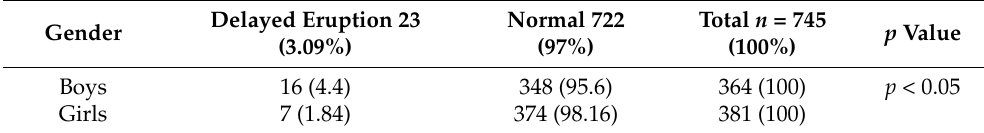
Table 2. Frequency distribution of delayed eruption cases according to different variables. n = 745 Boys Girls Total (100%) Delayed Eruption 16 (70%) 7 (30%) 23 Unilateral 13 (72%) 5 (28%) 18 Bilateral 3 (60%) 2 (40%) 5 cases with delayed eruption, 18 (78%) were unilateral, and 5 (22%) presented a bilateral delayed eruption within the upper centrals. The most commonly affected tooth was the upper left central incisor with a total number of 13 cases, followed by the upper right central incisor with a total number of 12 cases either unilaterally or bilaterally (Table 2). A retained primary tooth was found to be the most common cause of delayed erup- tion (10 cases (43.4%)), followed by early loss of a primary tooth (5 cases (21.7%)). (Figure (Table 3).